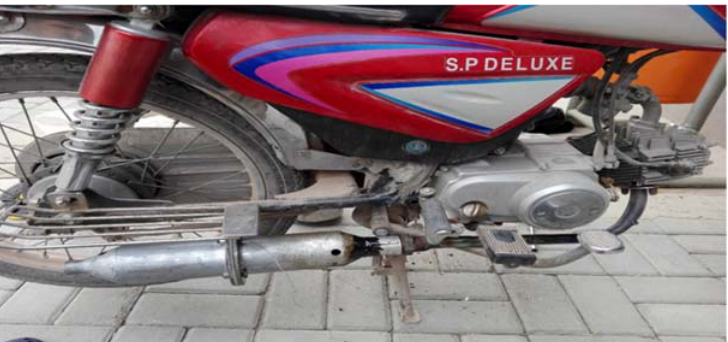
Figure 17. Catalytic converter mounted on engine exhaust for testing